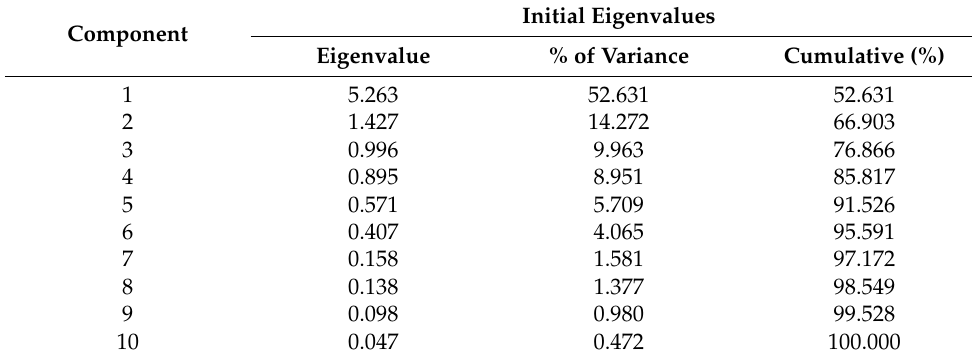
Table 3. Total variance explained in